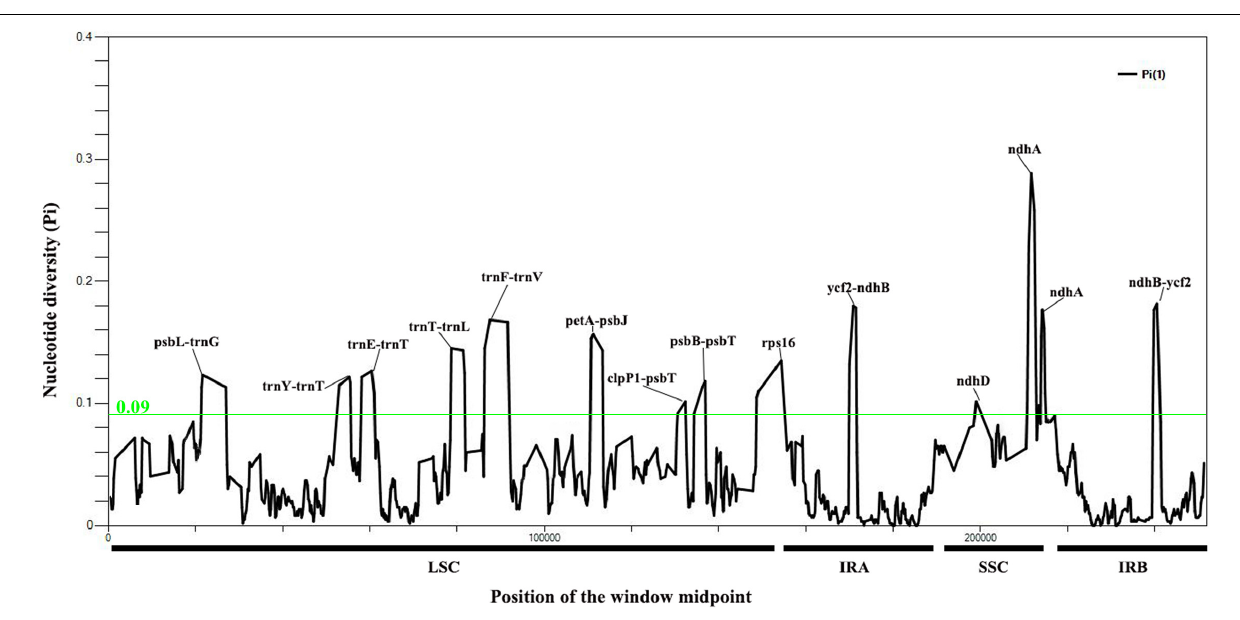
FIGURE 3 | Nucleotide variability values compared between the seven chloroplast genomes of Cypripedium using the window sliding analysis. ( X -axis indicates the position of the midpoint of the window, while Y -axis indicates the nucleotide diversity of each